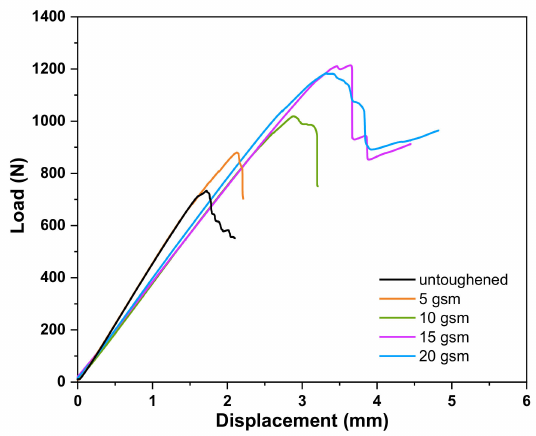
Figure 6. Load–displacement curves in ENF tests of untoughened laminate and the laminates interleaved with different areal densities of TPPI fiber